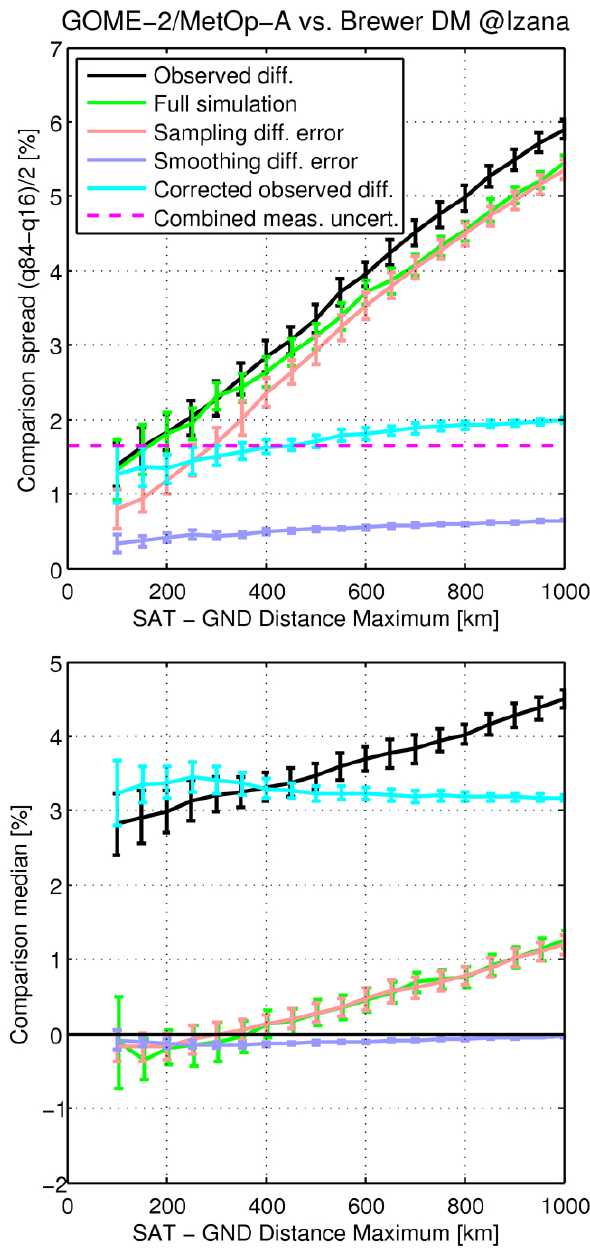
Figure 11. Upper panel: observed and simulated comparison spread between GOME-2/MetOp-A TOC measurements and correlative Brewer observations as a function of maximum co-location distance for the Izaña station over the period 2007–2010. Lower panel: com- parison median for the same sets of comparisons. Colours as in the upper